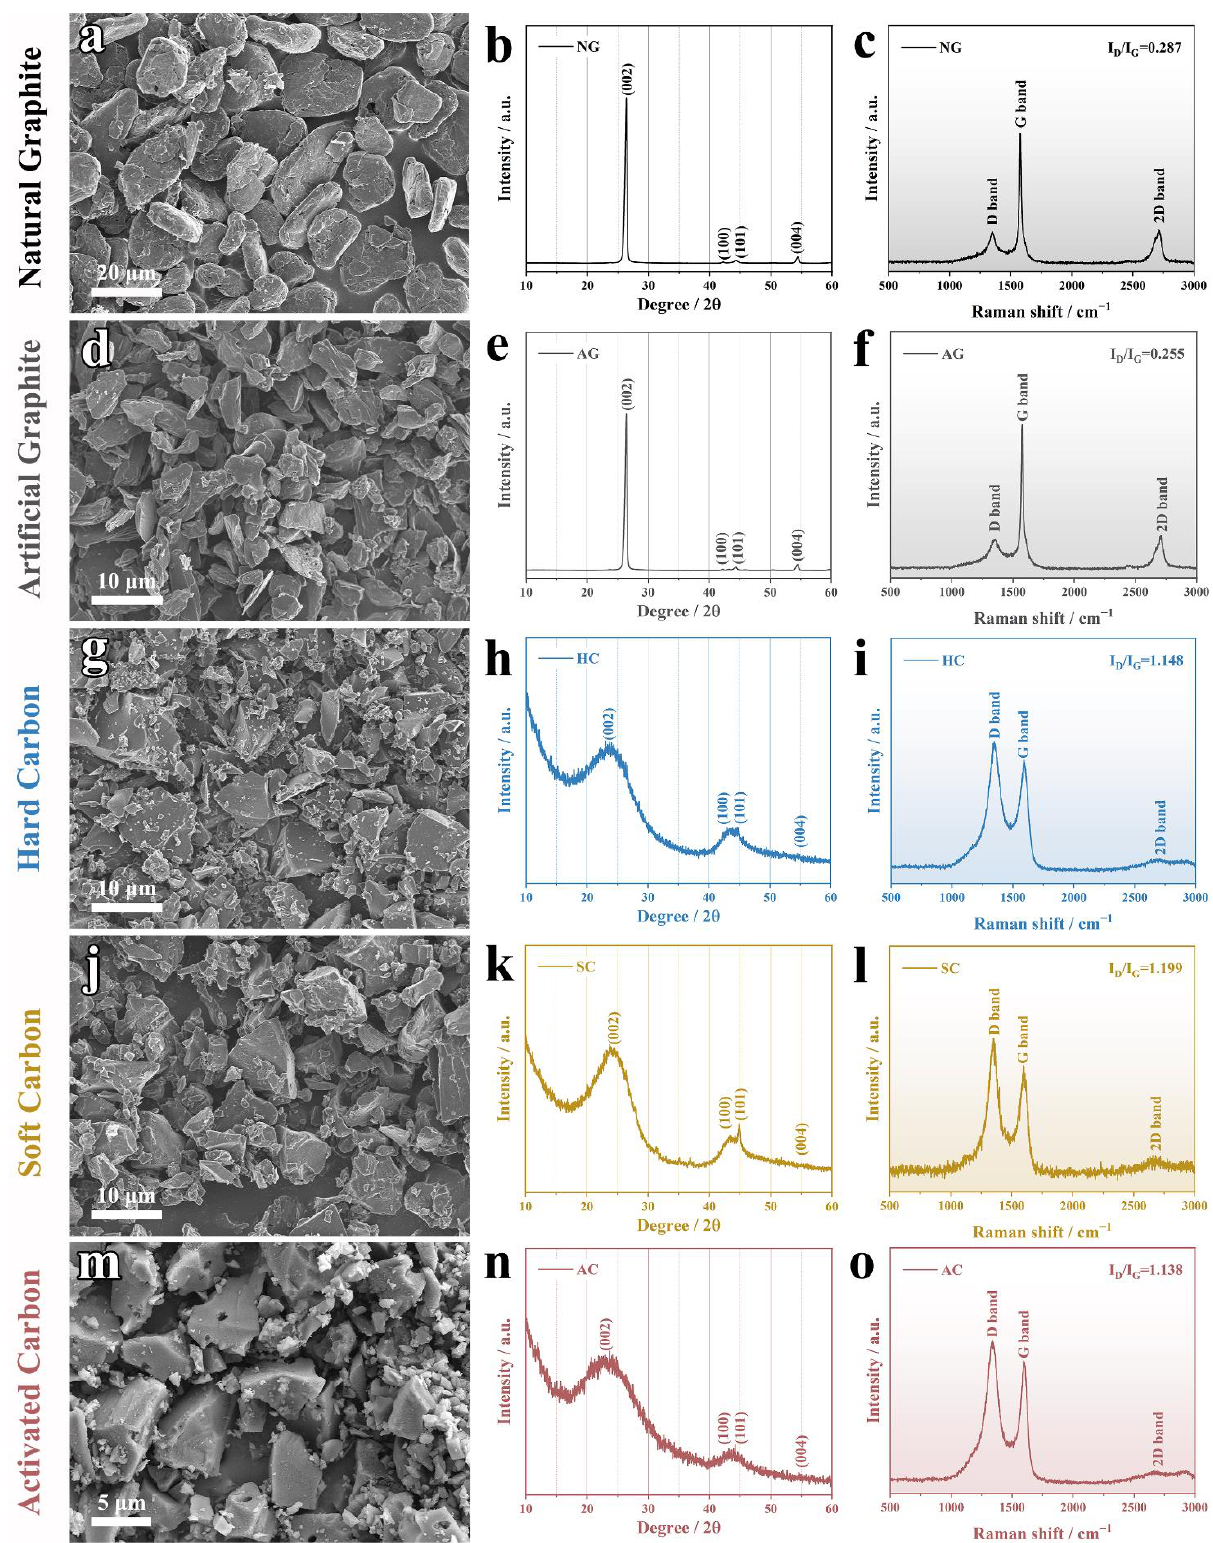
Figure 2. Morphology and structure of commercial carbons. SEM images, XRD patterns, and Raman spectra of NG ( a – c ), AG ( d – f ), HC ( g – i ), SC ( j – l ), and AC ( m – o ), respectively. With the potassium tablet as the counter electrode and a conventional 0.8M KPF 6 in EC/DEC (1:1 by volume) as the electrolyte, the electrochemical performances of all five carbons were well evaluated. As shown in Figure 3a,b, all carbons exhibited a relatively